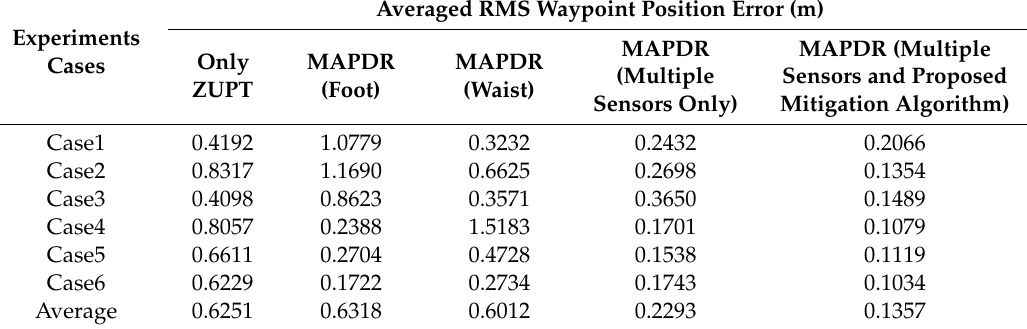
Table 5. Comparison of waypoint position